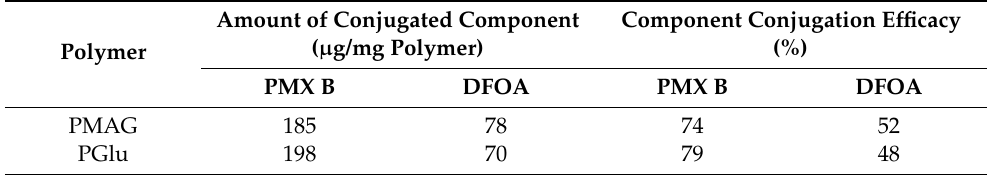
Table 6. Efficacy of DFOA conjugation with different polymers depending on the initial amounts of